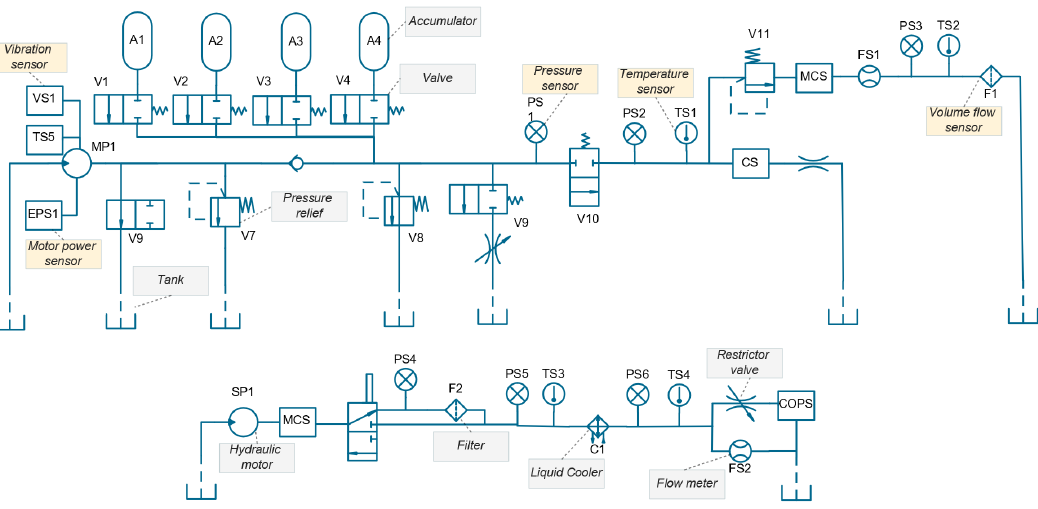
Figure 1. Illustration of the hydraulic system. Table 1. Hydraulic system sensors.